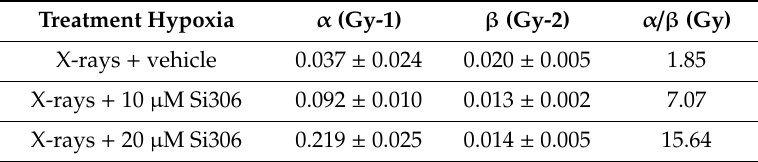
Table 3. α and β parameters estimated by fitting the cell survival to the linear-quadratic in normoxia (LQ) model in hypoxia. Values correspond to mean ± SEM; three independent